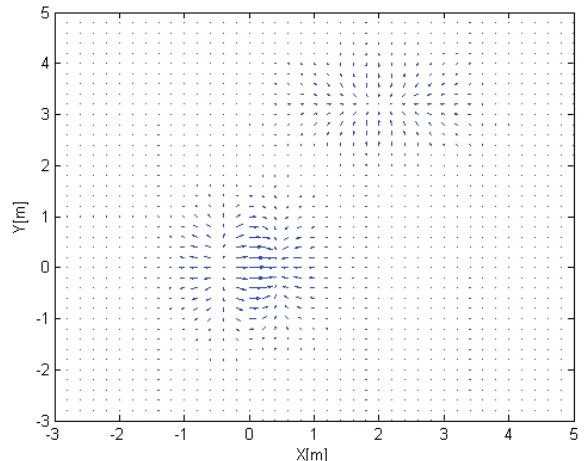
Figure 7. Spatial gradient.